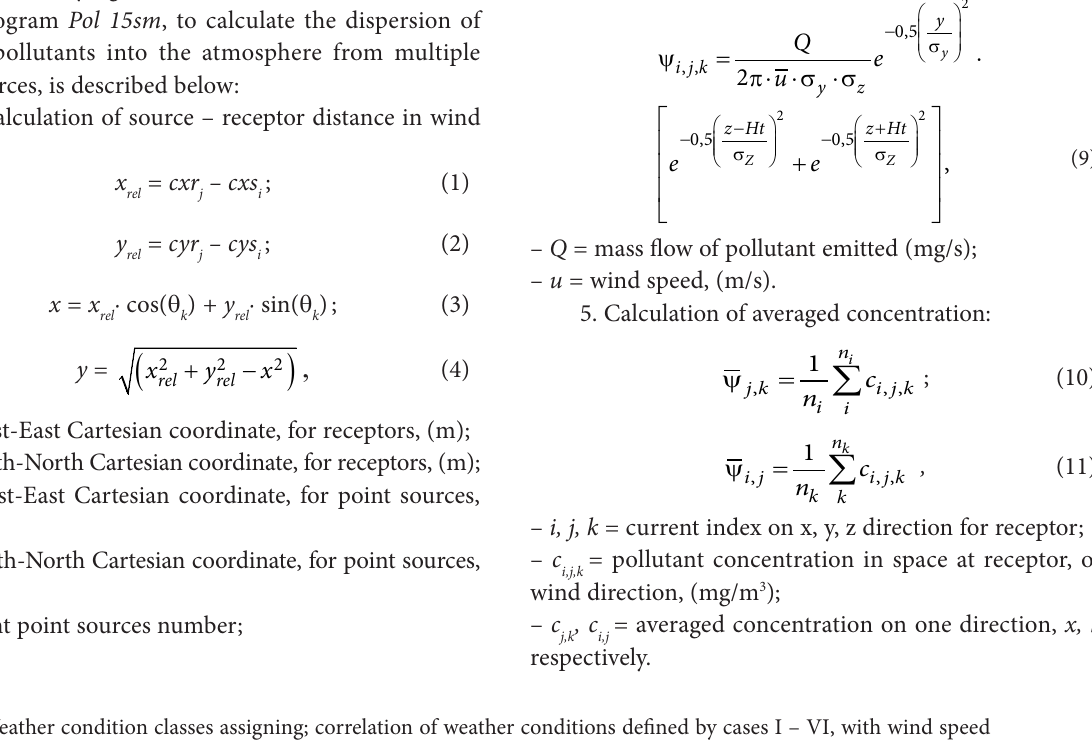
Table 1. Weather condition classes assigning; correlation of weather conditions defined by cases I – VI, with wind speed